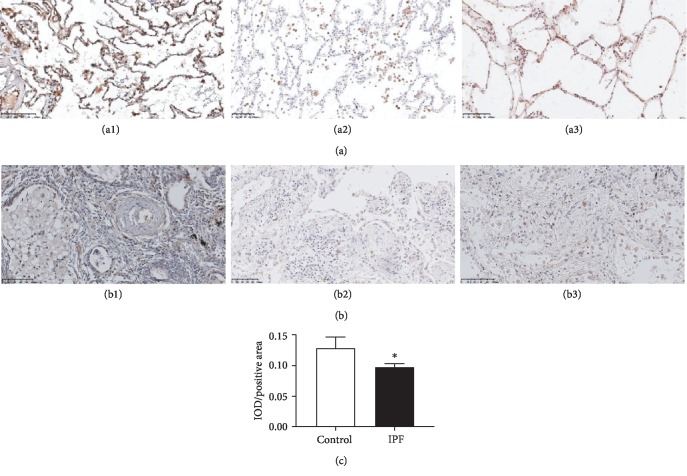
HYAL1 localization in normal and IPF lung tissues. (a) Images of healthy donor lung tissues and normal tissues from disease-free margins in non-small-cell lung tissue showing high HYAL1 expression; (b) images of IPF lung tissues showing low HYAL1 expression. The average IOD of IPF lung tissues (n = 3) was significantly lower than that of healthy controls (n = 3) (P < 0.05). The P values were calculated using the unpaired t test. HYAL1 is stained brown (DAB staining), and nuclei are stained blue (hematoxylin staining). The scale bars for the respective images are shown at the lower left corner of each image. (c) The average IOD of HYAL1 expression in IPF lung tissues (n = 3) was significantly lower than that in normal controls (n = 3) (P < 0.05). The P values were calculated using the unpaired t test. ∗P < 0.05.